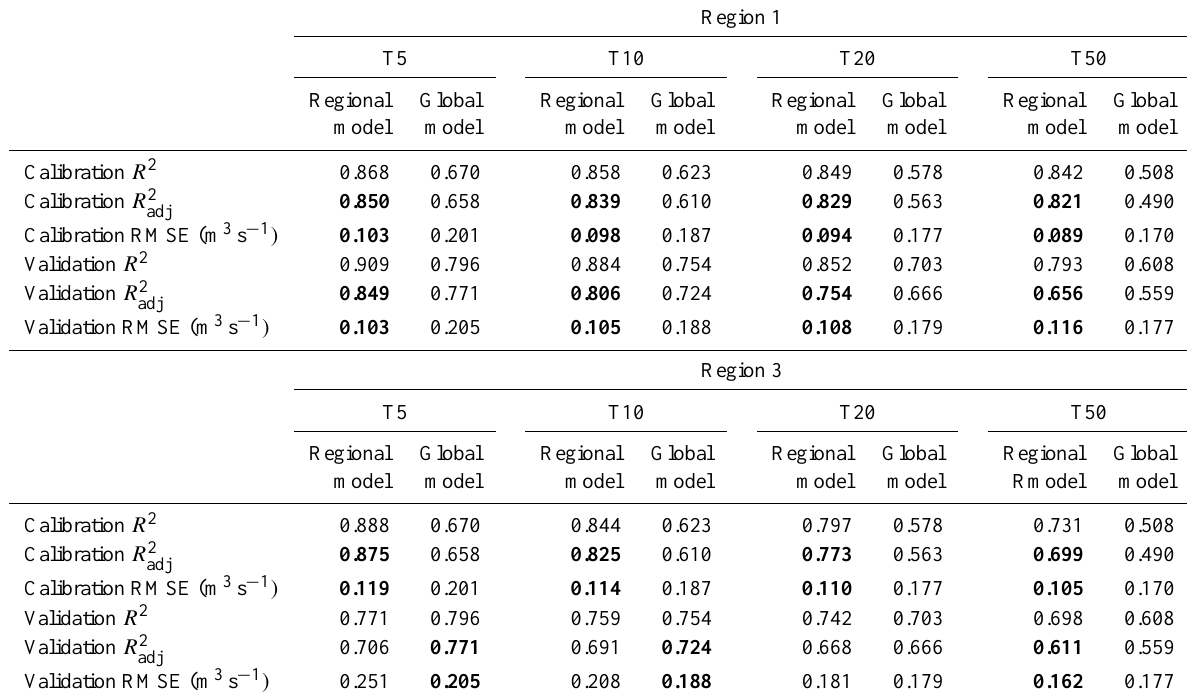
Table 6. Comparison of regional and global models using performance indices: R 2 (determination coefficient), R 2 coefficient) and RMSE (root-mean-square error). The numbers in bold are the highest values of indices for each return